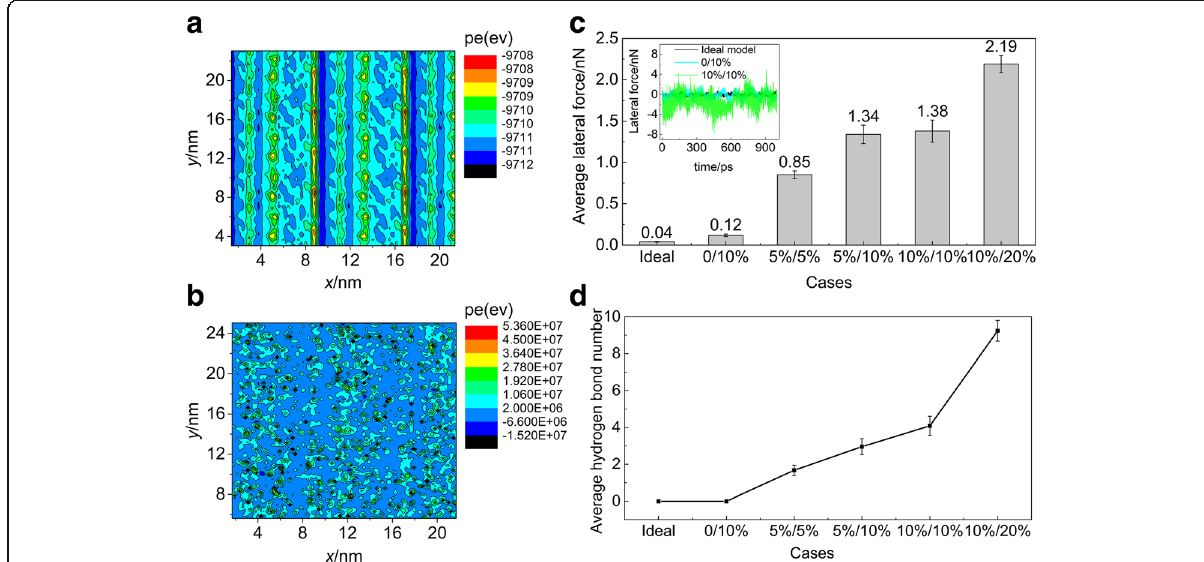
Fig. 3 a , b The interfacial potential energy between carbon nanotube and Si substrate. a Ideal model. b The hydroxyl groups ’ ratio on carbon nanotube and Si substrate is 10%/20%. c The average friction on carbon nanotube in the six cases. The inset shows friction of carbon nanotube with time in three cases in models a, b, and c. The hydroxyl groups ’ ratio of carbon nanotube and Si substrate in models b and c is 0/10% and 10%/10%, respectively. d The average hydrogen bond numbers in the six cases in